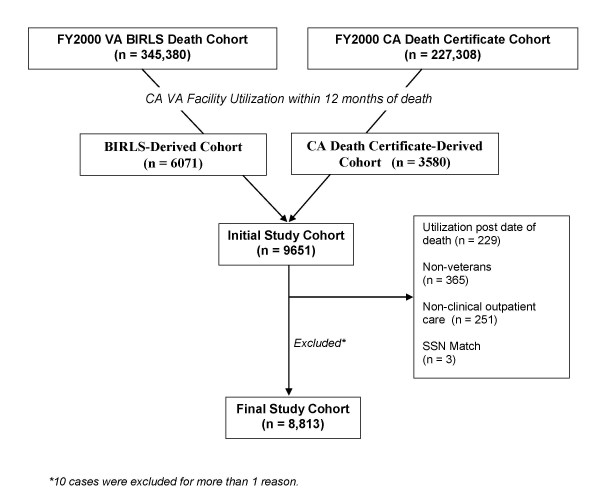
Cohort Development